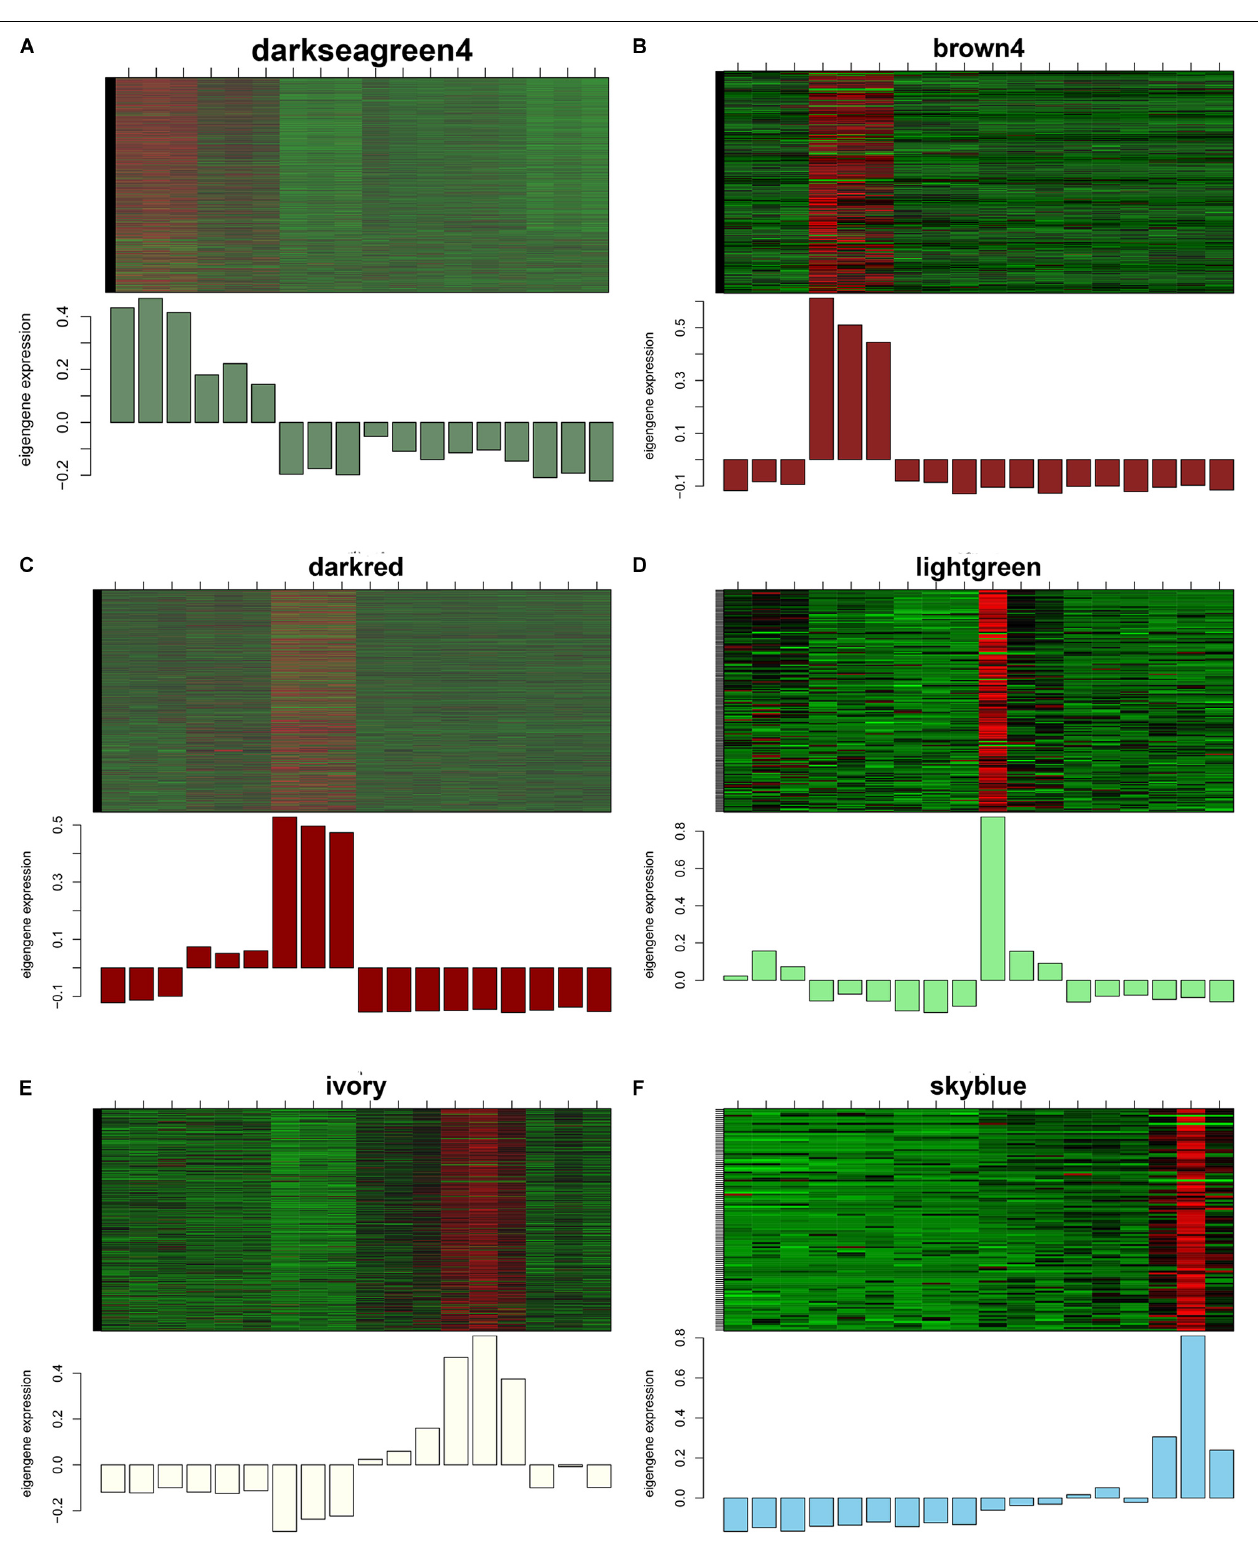
FIGURE 9 | Heatmap and bar plot of expression level in six stage-specific modules. Six modules represent (A–F) darksegreen4, brown4, darkred, lightgreen, ivory, and skyblue with specific expression in SYFG, F6G, F1T, SYFT, F6T, and F1T, respectively. Samples were sorted in the order of: SYFG1-3, F6G1-3, F1G1-3, SYFT1-3, F6T1-3 and